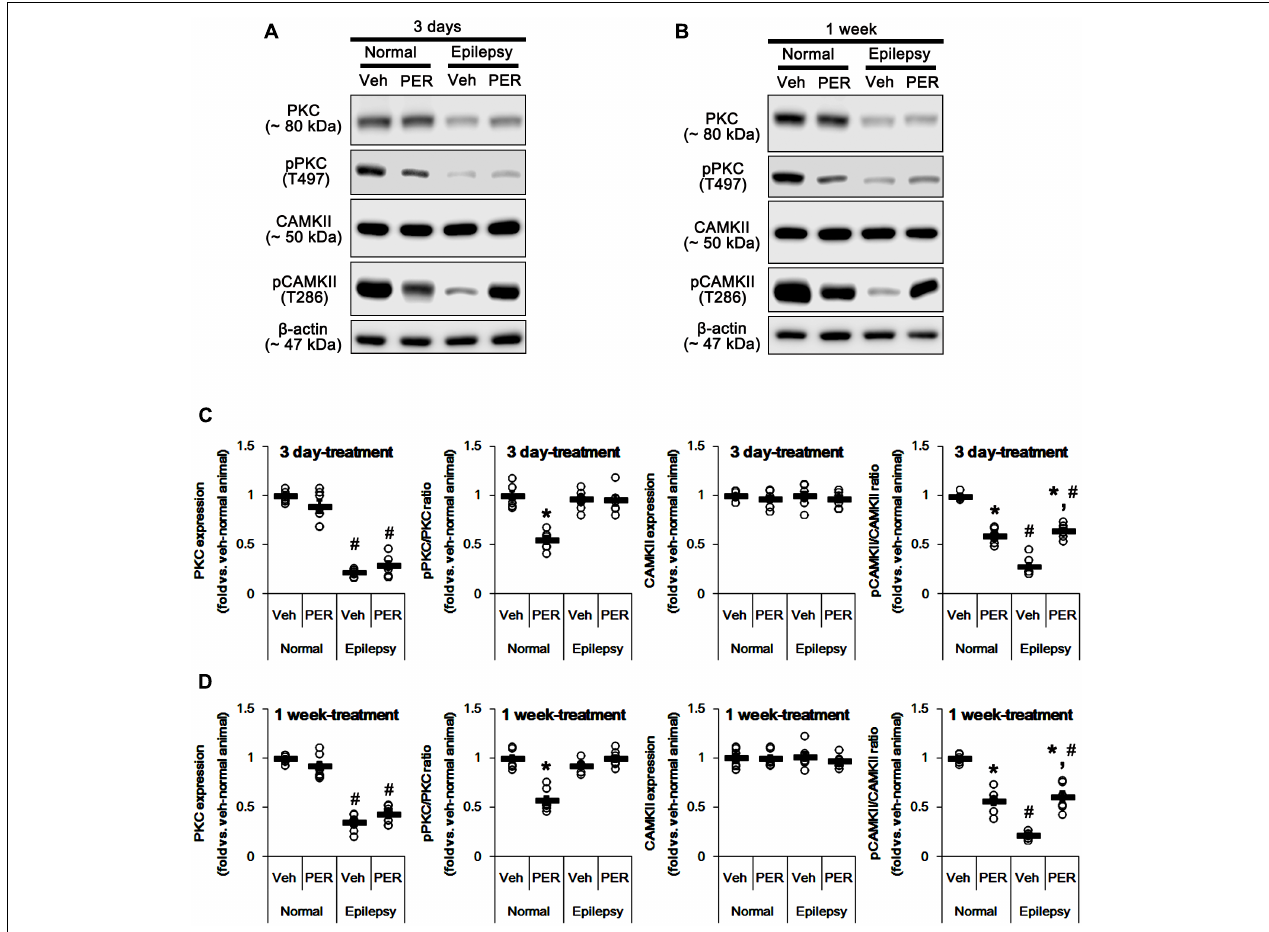
FIGURE 4 | Effects of perampanel on PKC and CAMKII expressions and their phosphorylations. (A,B) Representative images for western blot of PKC, phospho (p)-PKC, CAMKII, and pCAMKII in the hippocampal tissues obtained from 3-days (A) and 1-week treated groups (B) . (C,D) Quantifications of PKC, pPKC, CAMKII, and pCAMKII levels in 3-days (C) and 1-week treated groups (D) . Open circles indicate each individual value. Horizontal bars indicate mean value. Error bars indicate SEM ( ∗ , # p < 0.05 vs. vehicle-treated animals and normal animals, respectively; n = 7,